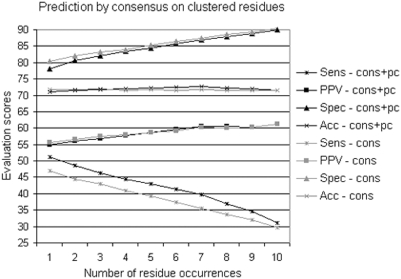
iJET consensus on clustered residues.iJET predictions for the Huang dataset using conservation (grey), and
conservation and physical-chemical properties (black). Evaluations
concern residues occurring  times over 10 runs of JET. For each , we plot the average evaluation over all proteins in
the Huang datset.